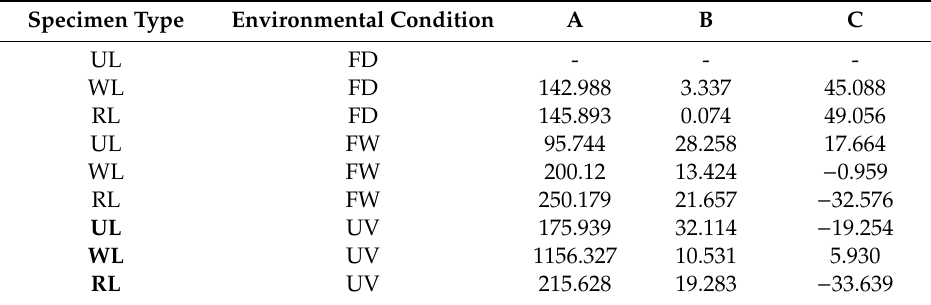
Table 5. Constant values in Equation (1) for FD condition.